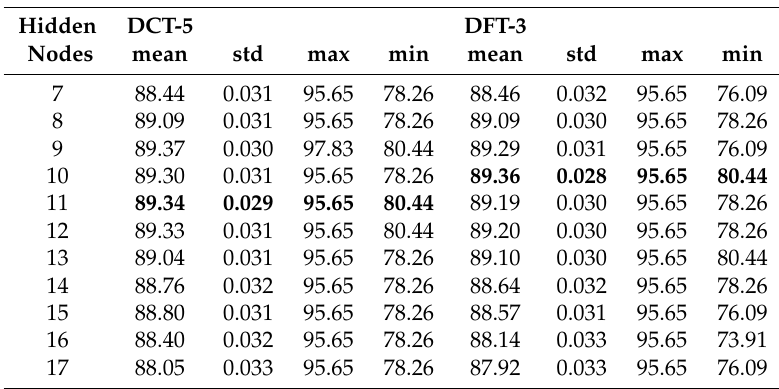
Table 1. The binary classification problem. A comparative summary of the network accuracy obtained for the best combinations of the DCT (five features) and the DFT (three features) depending on the hidden nodes used. The LOO-CV was performed and the experiments were repeated 1000 times. For each feature set, there is an optimum number of hidden nodes that provide the best results. In the table the bests accuracy results are highlighted in bold.